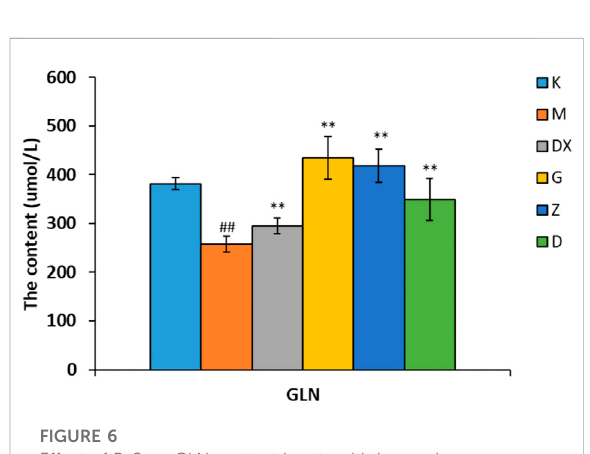
FIGURE 6 Effect of R-S on GLN content in rats with insomnia.